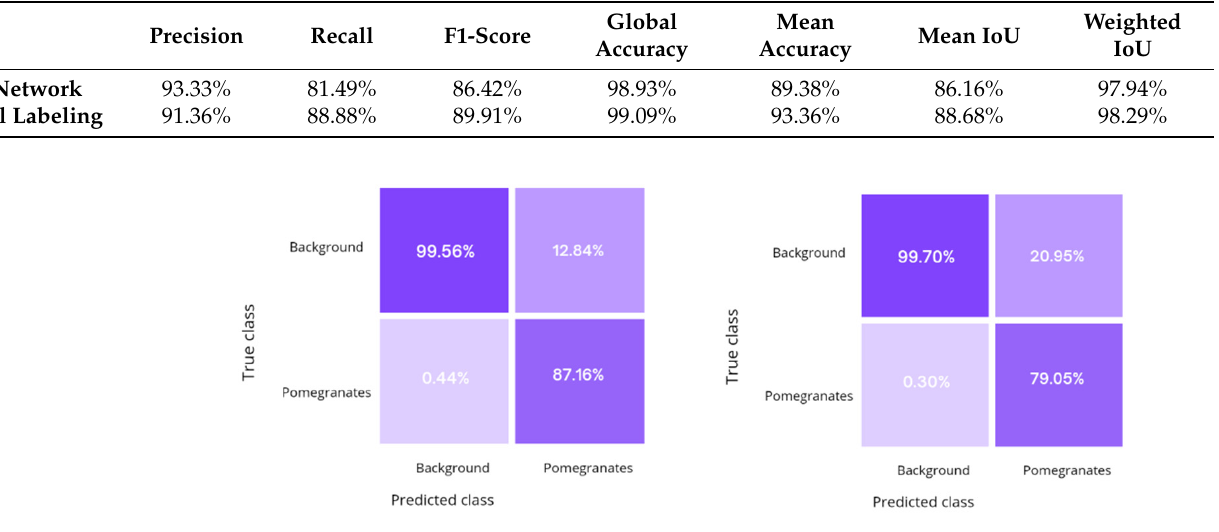
Figure 14. Confusion matrices for the manual labeling network ( left ) and the FIA network ( right ).